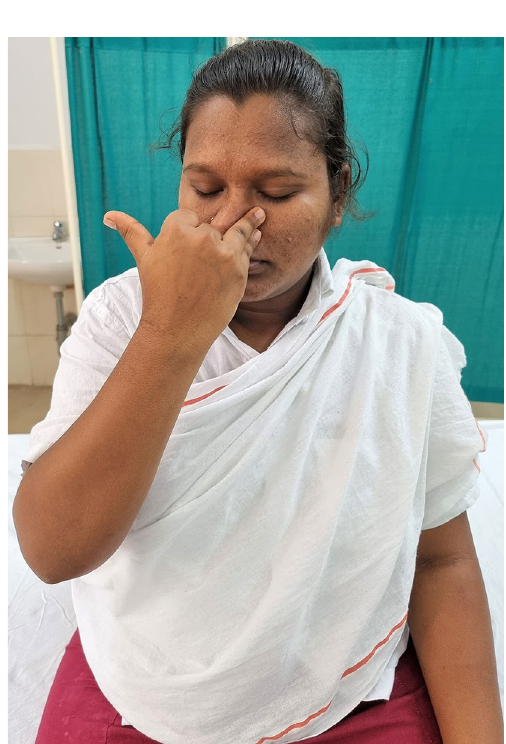
Figure 11. Anulom-Vilom or Nadisodhana